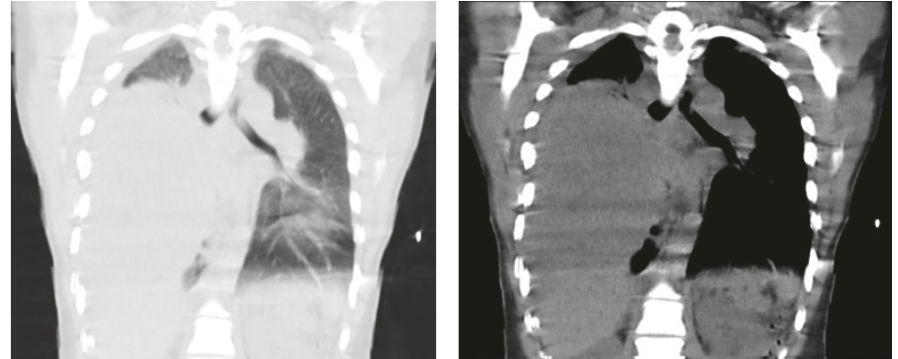
Figure 2: Initial plain chest CT showing the mass.